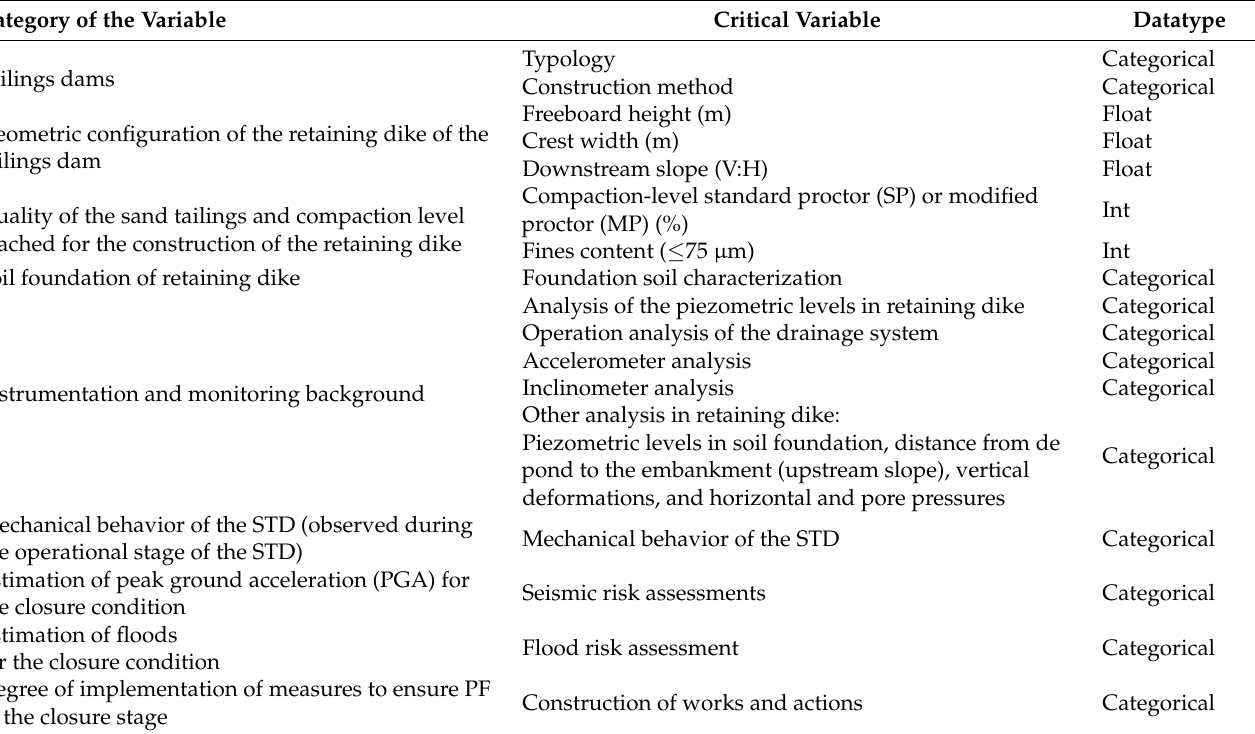
Table 1. Critical variables that define PS in STD. Modified from